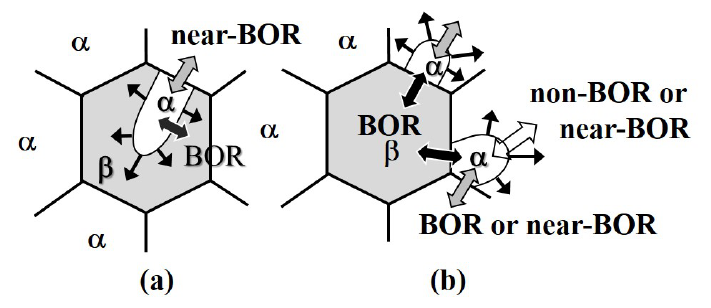
Figure 5. Schematic representations of nucleation and growth modes of DBOR variants. Growth of DBOR variants by ( a ) coherent interfaces and ( b ) semi-coherent or incoherent in α → β transformation.